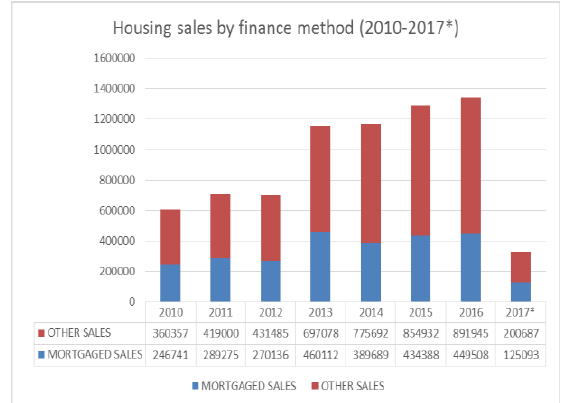
Figure 8. Housing Sales by the Financing Method